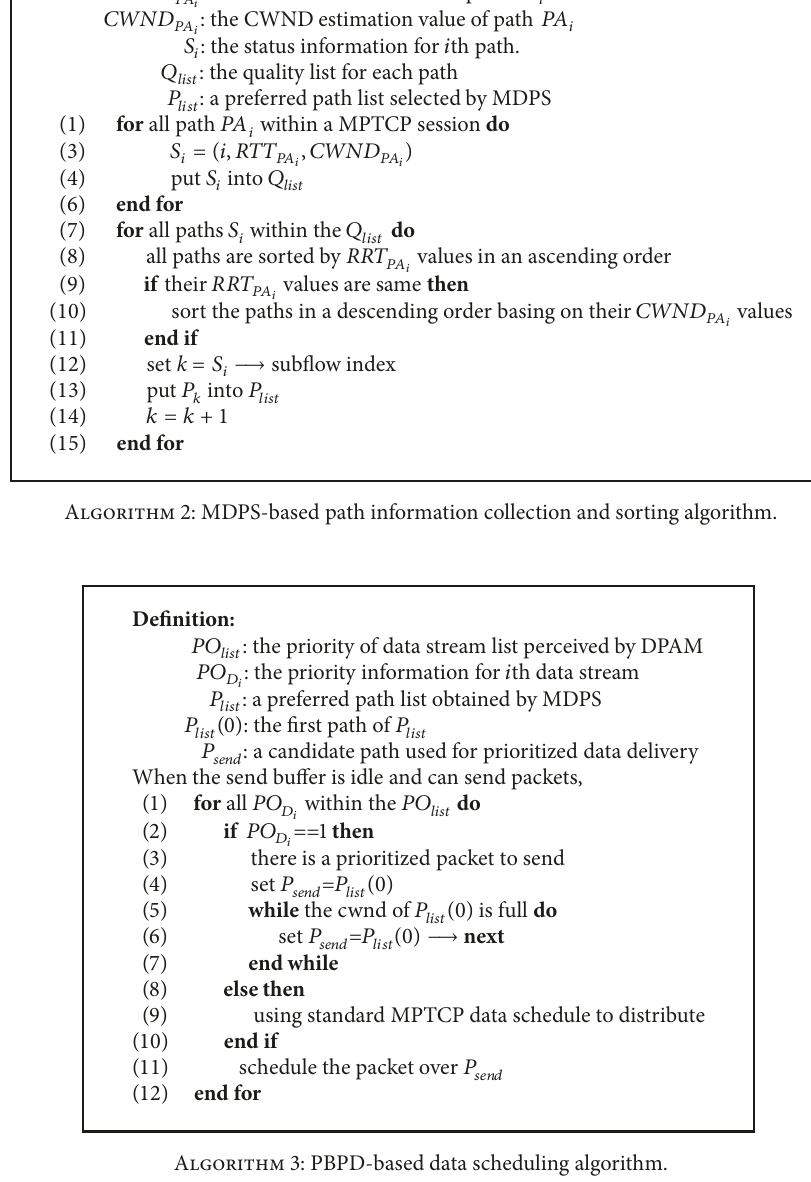
Algorithm 3: PBPD-based data scheduling